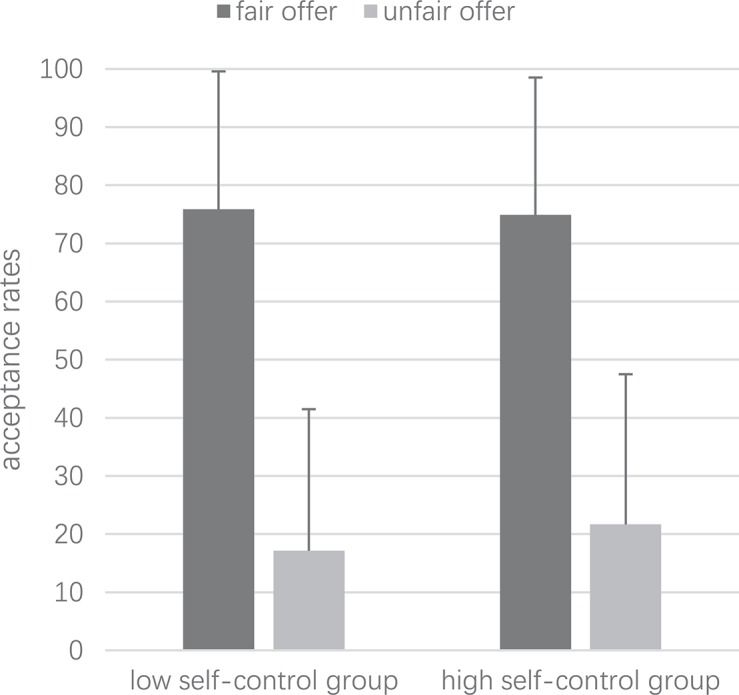
UG acceptance rates (%). The figure shows the acceptance rates of fair offer (dark area) and unfair offer (light area) for low self-control group (left side of picture) and high self-control group (right side of picture). Error bars represent positive standard errors.